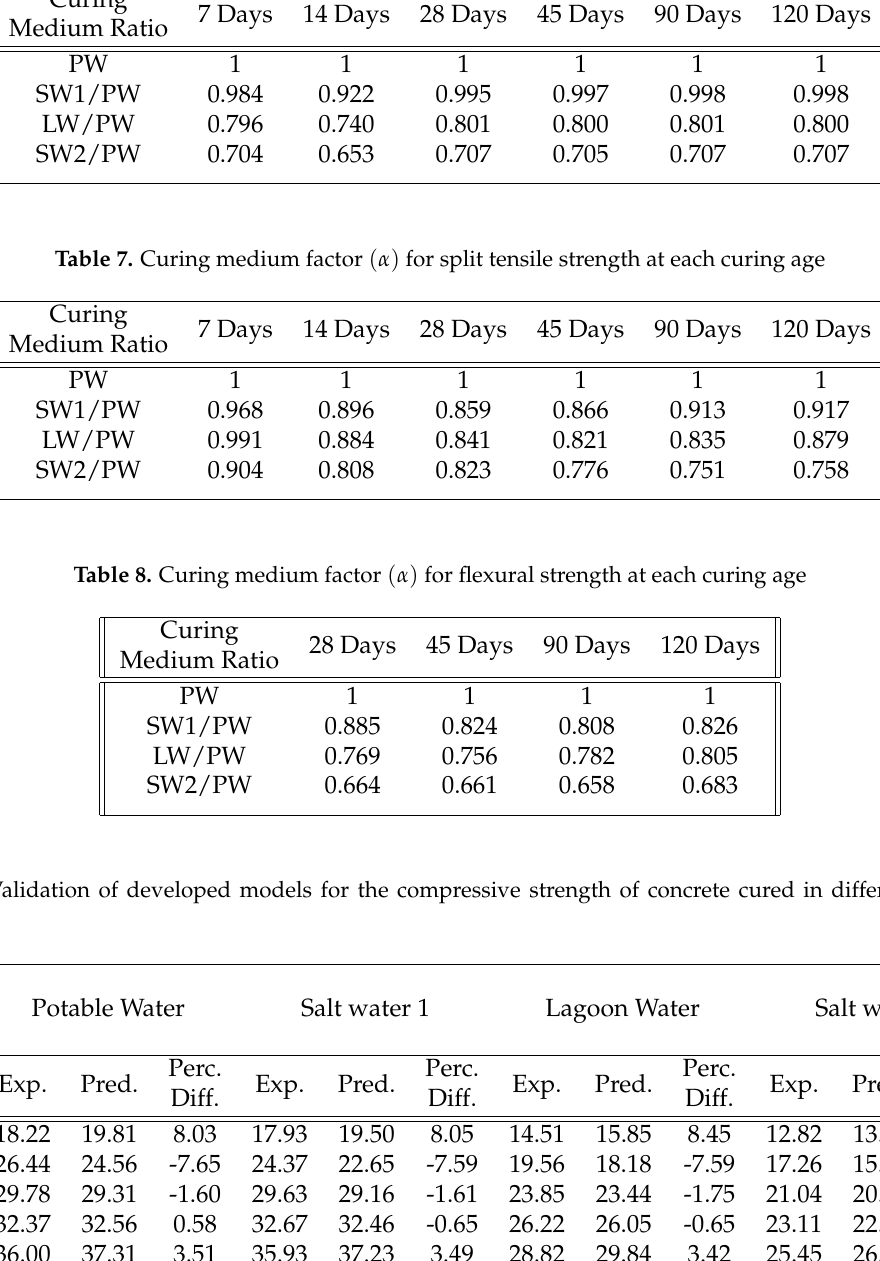
Table 6. Curing medium factor ( α ) for compressive strength at each curing age Curing